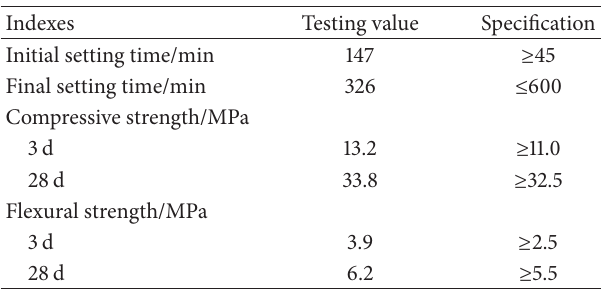
Table 4: Basic properties of cement.